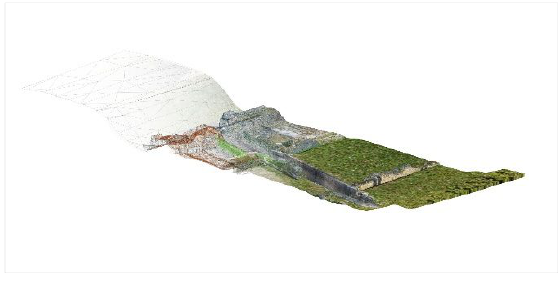
Figure 3. Render of sector number 03, with highlighted, on the left side, the structure of the 3D mesh underlying the